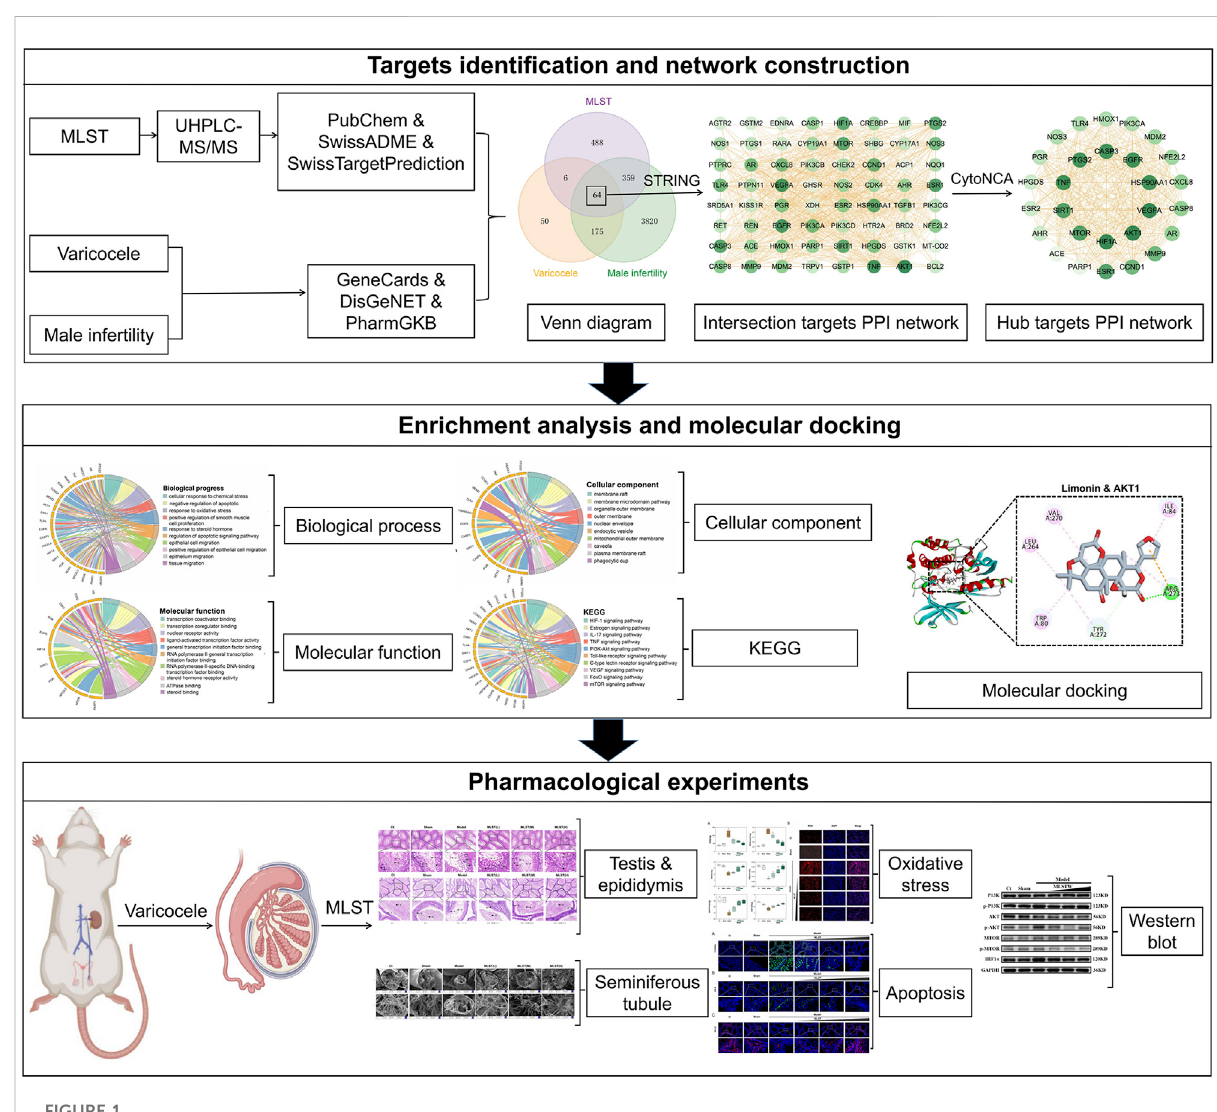
FIGURE 1 Flowchart for the network analysis and pharmacological experimental methods used in this study.